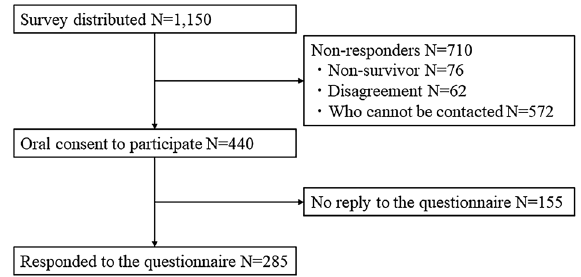
Figure 1. Patient selection for cross-sectional